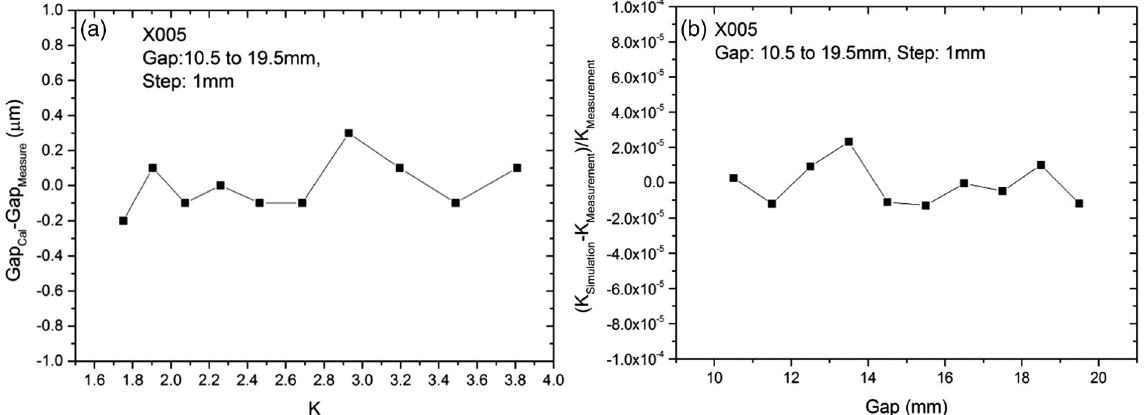
FIG. 4. Test of the interpolation using gap steps of 0.5 and 1.0 mm. (a) Differences of the gap are well within 0 . 4 μ m; (b) Differences of the K-parameter are within (cid:3) 2 × 10 − 5